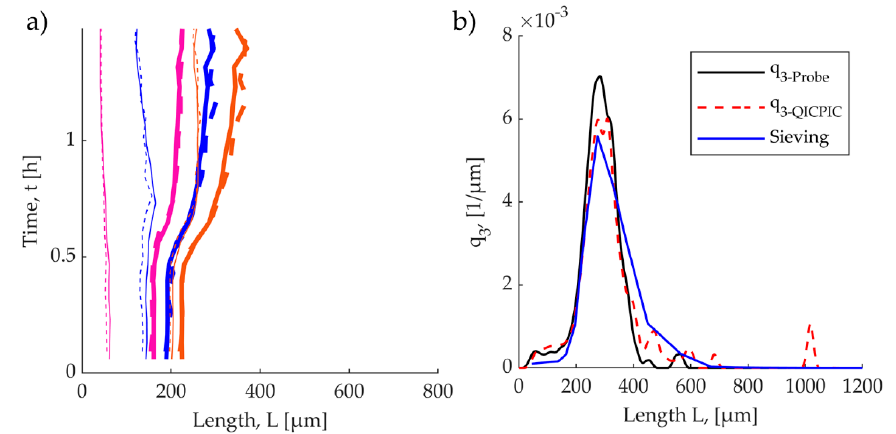
Figure 8. ( a ) Percentiles and mean values of the crystal size distributions from Figure 7 thin lines - percentiles of the q 0- distribution; bold lines – percentiles of the q 3 -distributions; Solid lines - percentiles and mean values shadowgraphic probe; dashed lines - percentiles and mean values QICPIC; brown; magenta − 0.15 and 0.85 percentile of the corresponding distribution; blue - mean size of the corresponding distribution. ( b ) Comparison of the last mass distribution: shadowgraphic probe, QICPIC, sieve analysis.